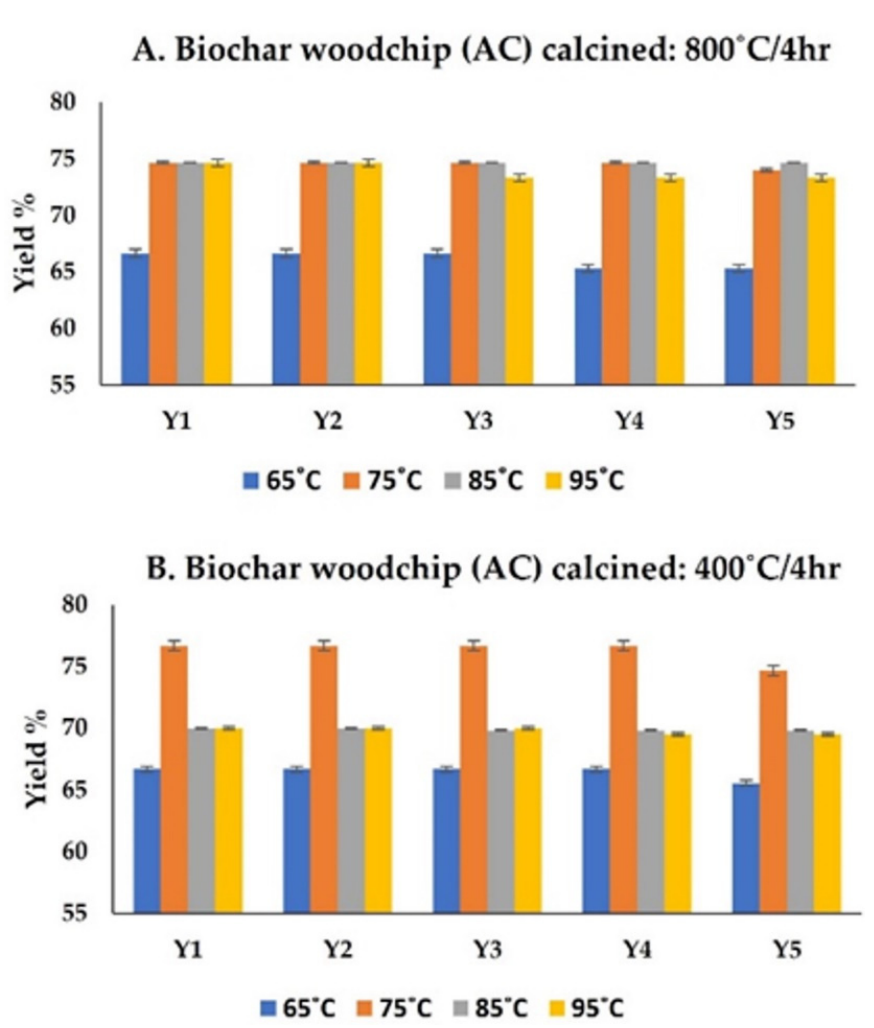
Figure 2. Catalyst reusability performance over reaction temperature. ( A ) 800 °C; ( B ) 400 °C.